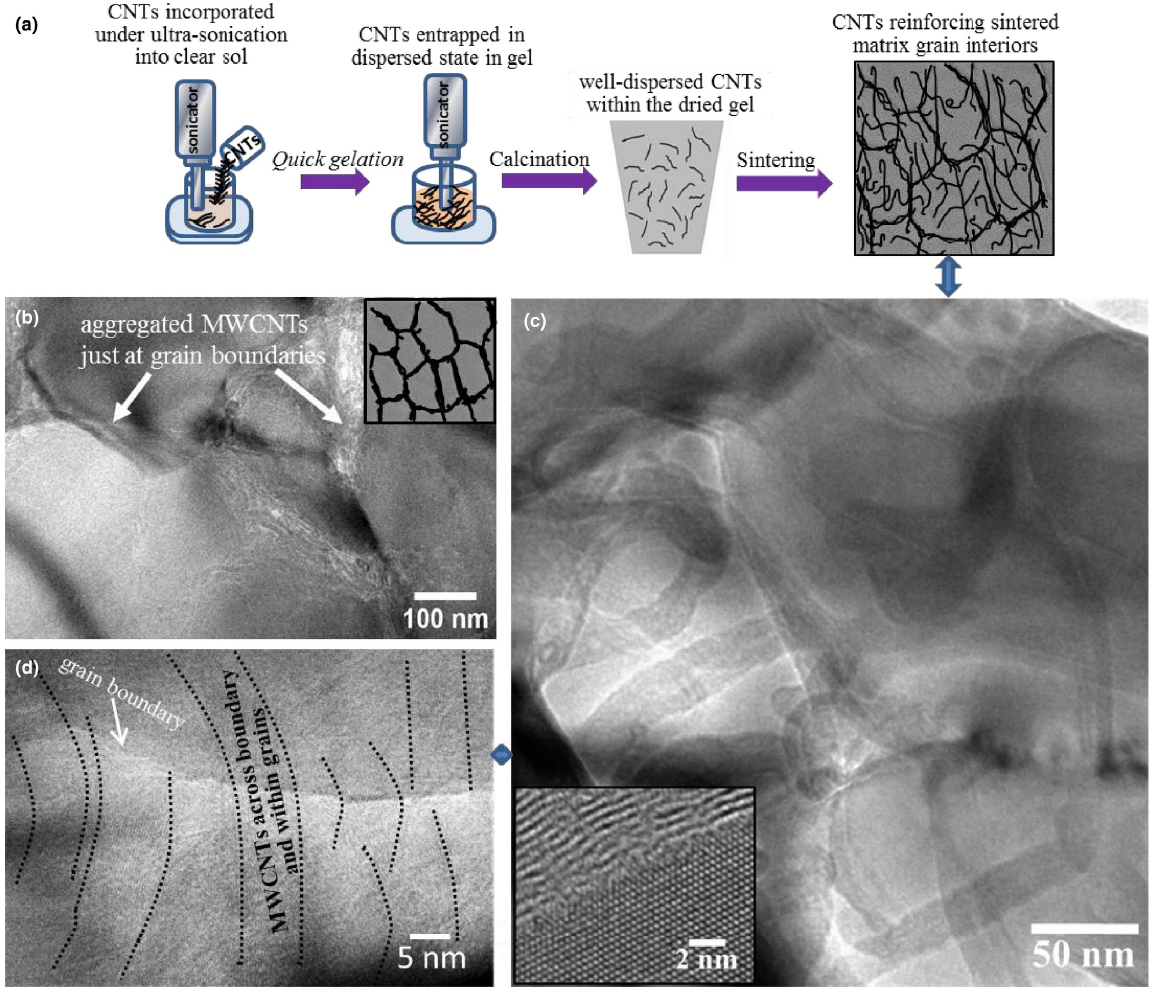
Figure 2: (a) The schematic diagram of the processing route and the ideal microstructural type with intergranular and intraparticle MWCNT; (b) the representative TEM images of "ball milling" and (c, d) "sol gel" Al 2 O 3 -5vol%MWCNT. In c and d, we can see that the matrix particles exist in the MWCNT. (c) High-resolution images at the interface between MWCNT and Al 2 O 3 particles in the matrix